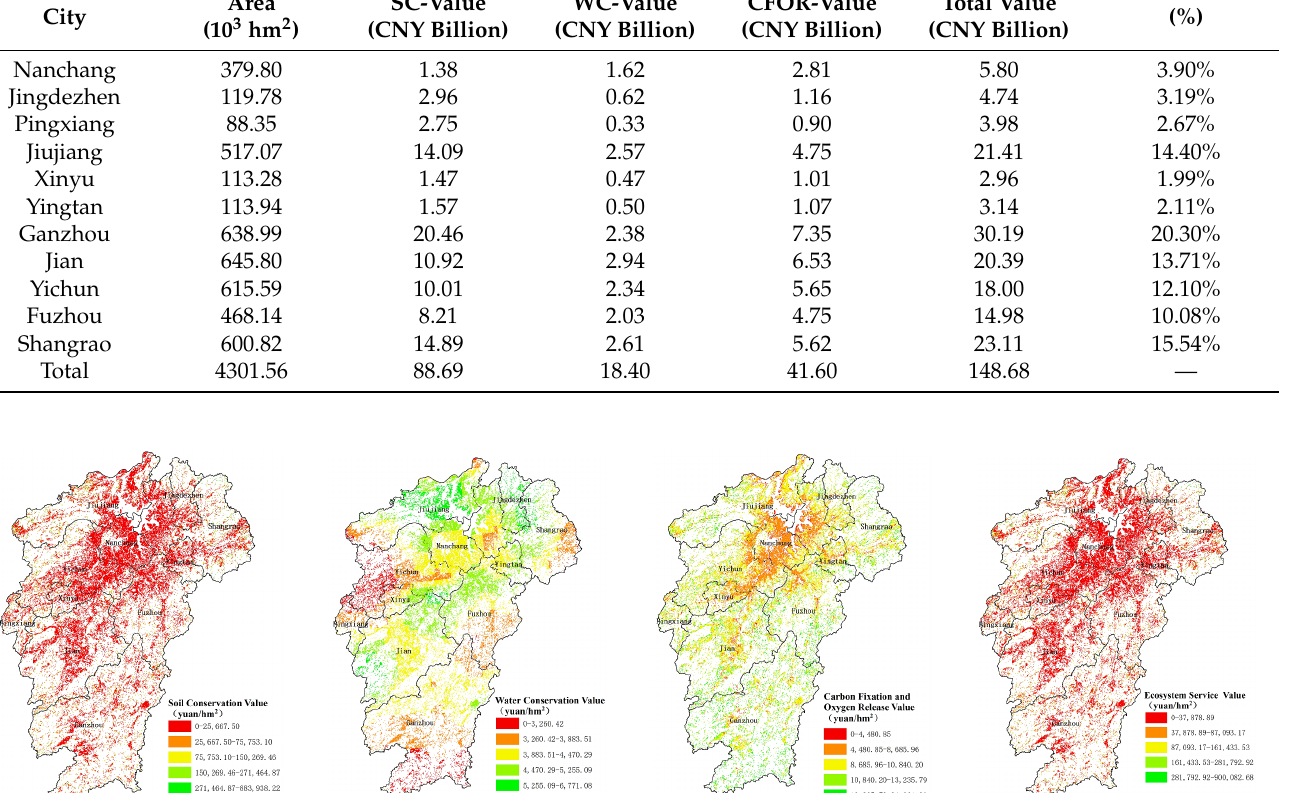
Figure 1. Spatial distribution map of unit price of cultivated land resource asset ecosystem service function value.